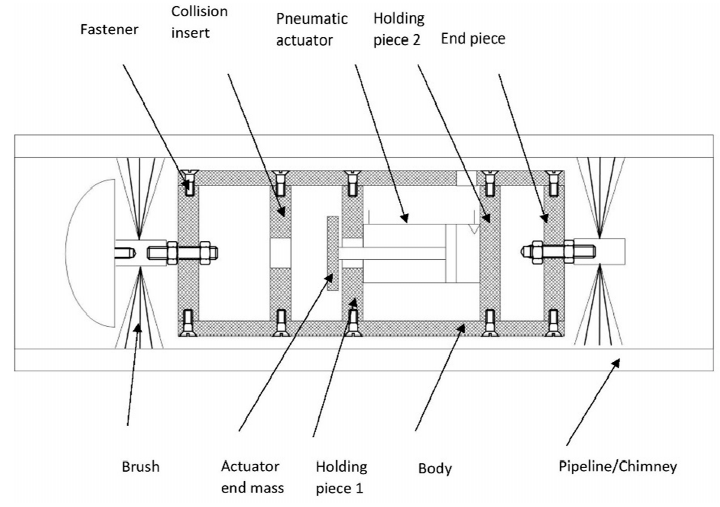
Figure 2. The robot’s configuration .